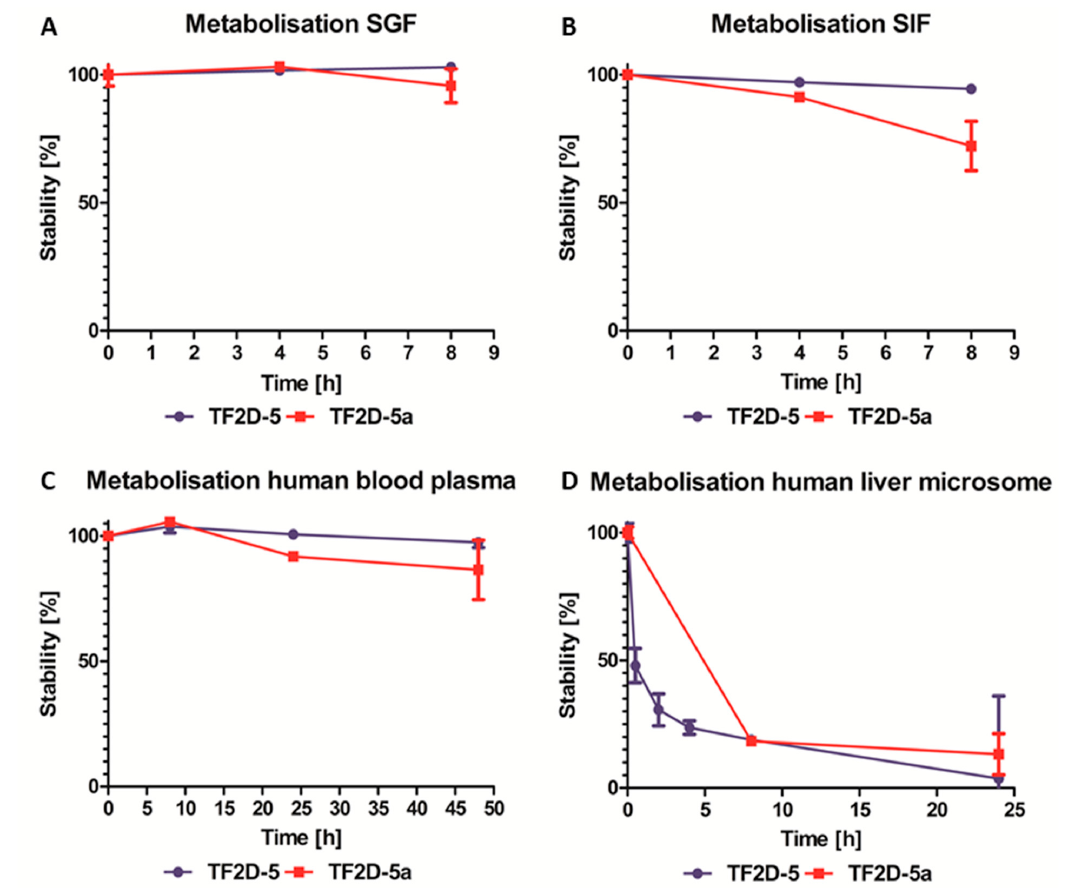
Figure 12. Stability assay of TF2D-5 and TF2D-5a using different simulated human body fluids. ( A ) Stability of compounds in simulated gastric fluid (SGF). The simulated gastric fluid consisted of 2 mg/mL sodium chloride, 3.2 mg/mL pepsin, and 80 mM HCl; pH 1. ( B ) Stability of TF2D-5 and TF2D-5a in simulated intestinal fluid (SIF). Simulated intestinal fluid consisted of 6.8 mg/mL po- tassium dihydrogen phosphate, 10 mg/mL pancreas powder, and 15.4 mM NaOH; pH 6.8. ( C ) Sta- bility of TF2D-5 and TF2D-5a in human blood plasma. K3EDTA human blood plasma was pur- chased from BioTrend. ( D ) Stability of TF2D-5 and TF2D-5a in human liver microsomes. Human liver microsomes consisted of 6 mg/mL protein (containing Cytochrome P450 (CYP) enzymes), 75 mM sucrose, 1.3 mM NADPH, 3.3 mM D-glucose-6-phosphat, 0.2 u/mL D-glucose-6-phosphat dehydrogenase, 3.3 mM magnesium chloride, and 100 mM potassium phosphate; pH 7.4.